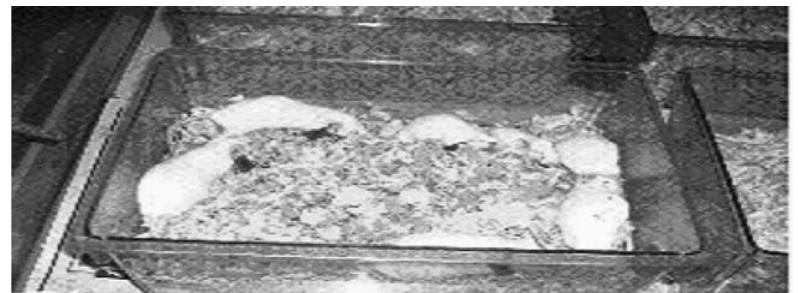
Fig. 1 NOD mice for in vivo